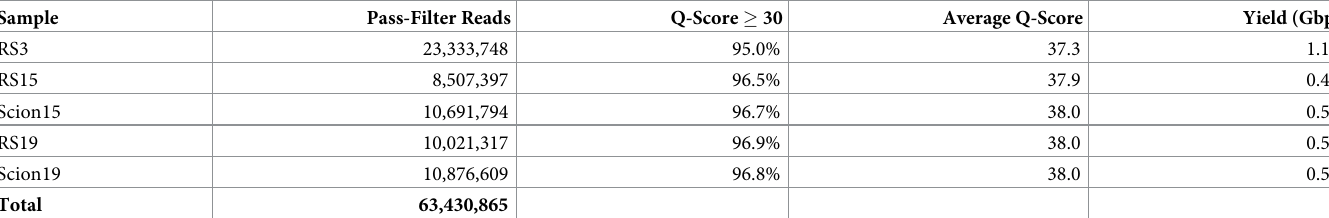
Table 1. Summary of small RNA sequencing reads.